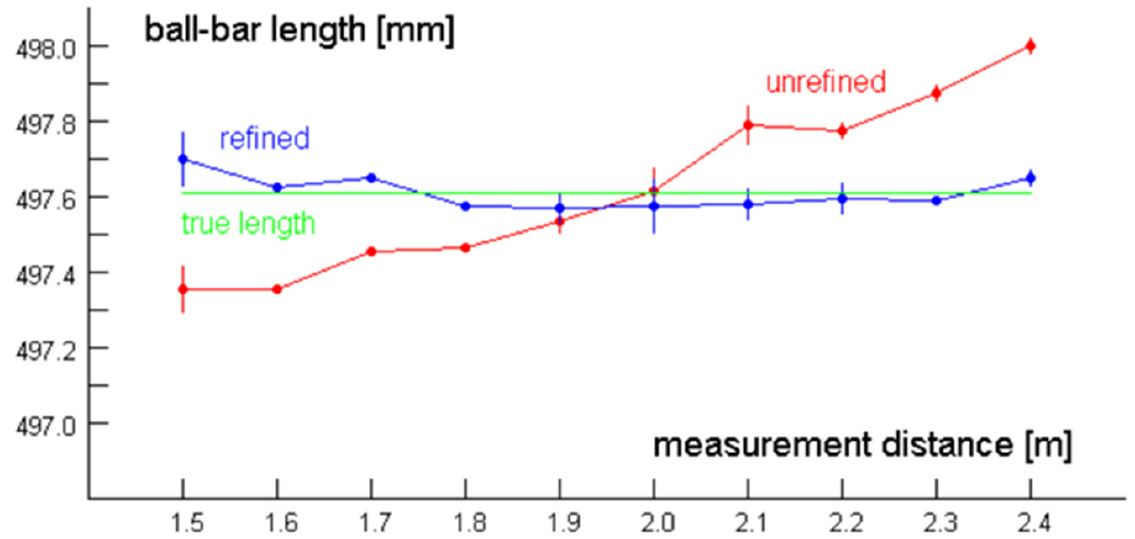
Figure 4. Ball-bar length measurement results depending on object distance.